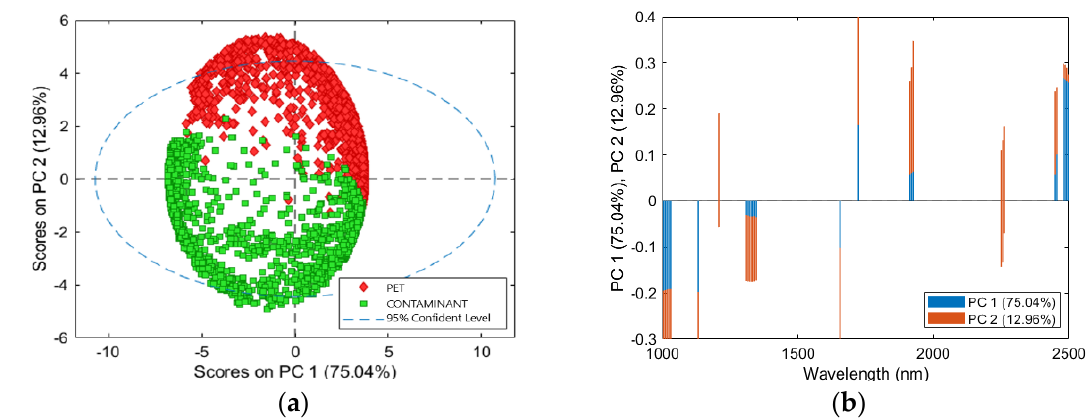
Figure 6. PCA results for the preprocessing Set 2 (SNV + MC): PCA score plot (PC1-PC2) ( a ) and loadings plot of PC1 and PC2 related to PET and contaminant classes ( b ).